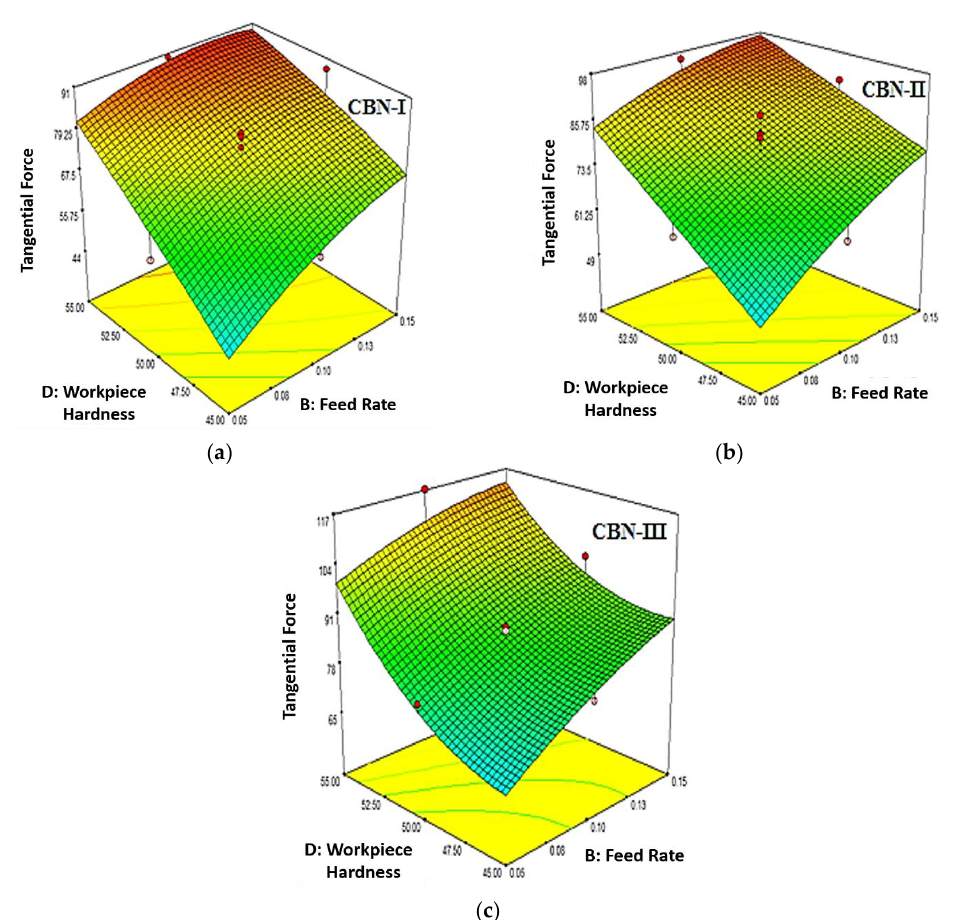
Figure 6. ( a ) Effect of Work Material Hardness (D) and Feed Rate (B) on Tangential Force (F c ) for CBN-I insert; ( b ) Effect of Work Material Hardness (D) and Feed Rate (B) on Tangential Force (F c ) for CBN-II insert; ( c ) Effect of Work Material Hardness (D) and Feed Rate (B) on Tangential Force (F c ) for CBN-III insert.